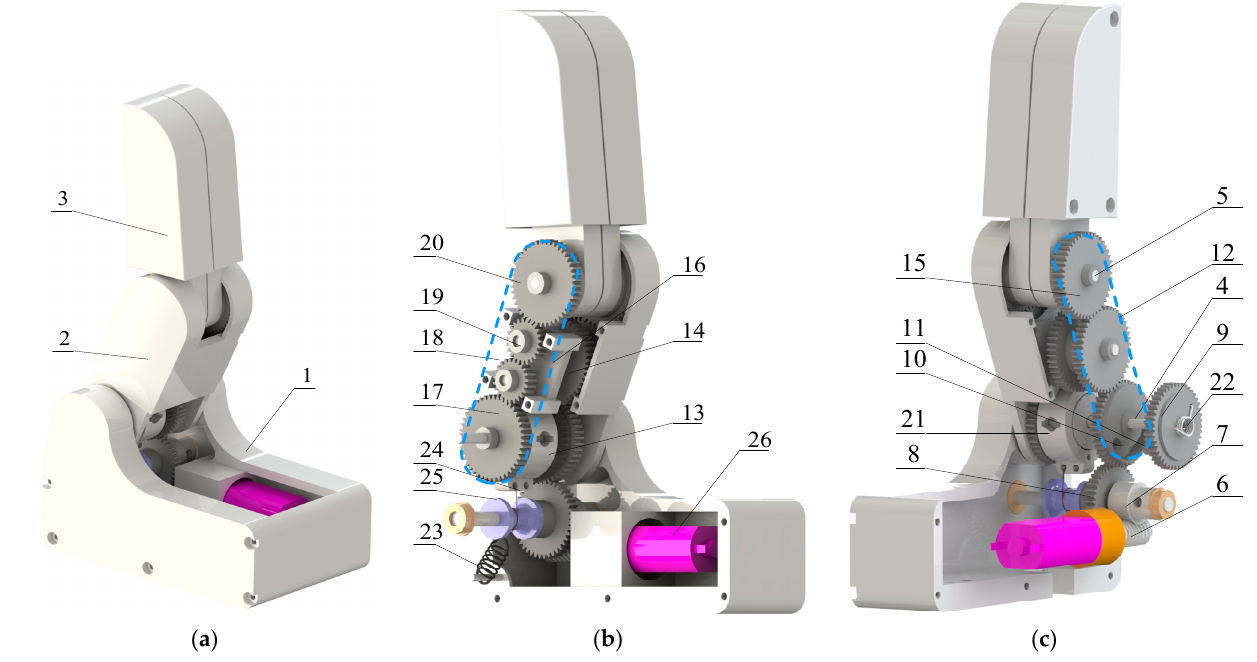
Figure 4. Mechanical structure of the ESMGM finger: ( a ) Overall structure; ( b ) left side stereoscopic view; ( c ) right side stereoscopic view. Components: 1—base; 2—proximal phalange; 3—distal pha- lange; 4—proximal joint axis; 5—distal joint axis; 6—worm; 7—worm gear; 8—transition gear; 9— driving gear; 10—partial effective driven disc; 11—bump; 12—parallel grasping gear train; 13–15— first gear to third gear; 16—coupled grasping gear train; 17–20—fourth gear and seventh gear; 21— electromagnetic switching device; 22—torsion spring; 23—tension spring; 24—string; 25—reeling sleeve; 26—motor.